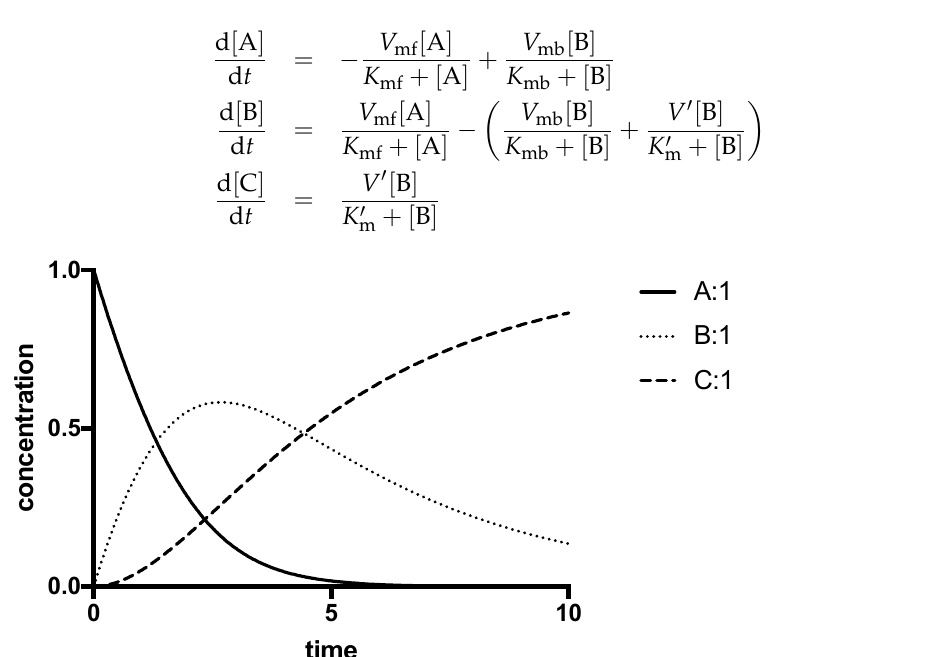
Figure 1. Behaviour of a simple two-enzyme model system. V f and V b are the maximum velocities k cat [ E ] ) of E1 operating in the forward and backward directions, respectively. K mf and K mb are the respective Michaelis constants, and V (cid:48) and K (cid:48) m are the maximum velocity and K m value for E2. Square brackets indicate concentrations. Lower panel: time-course of the reaction with V f = 1, V (cid:48) = 2.5, K mf = 1, K (cid:48) m = 10 and V b = 0. Initial values: A = 1; B = 0; C =